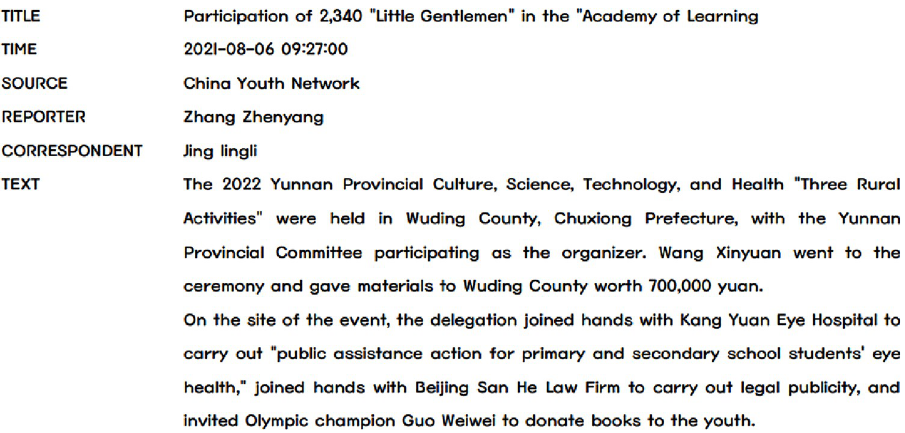
Fig 2. Information schematic of the news sample. Note: To meet the need for privacy protection, the names of persons and organizations in the information in the figure are all pseudonyms. It should be emphasized that the official website (https://www.gqt.org.cn/) of the Young Communist League of China (CYLC) is only available in Chinese. Therefore, the news content and terminology used in the manuscript are translations of the source content.